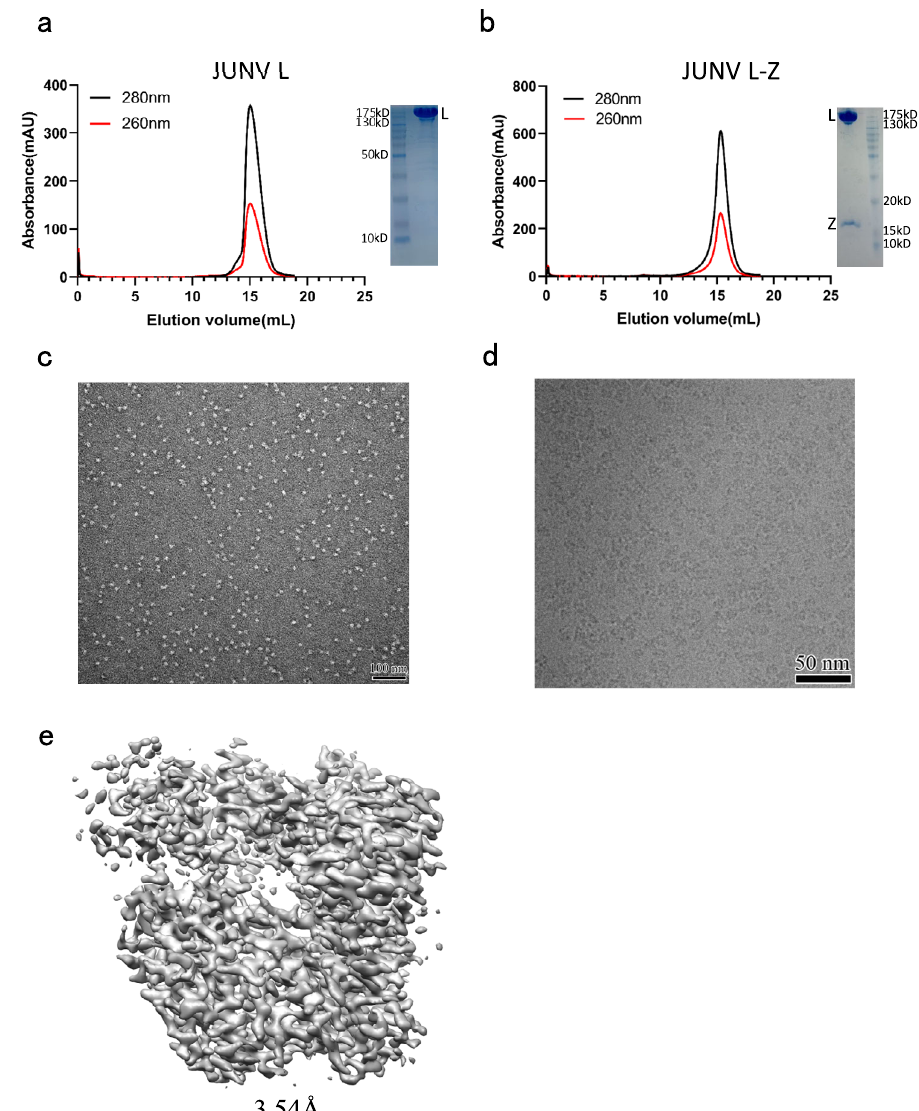
Fig. 1 Biochemical characterization and cryo-EM structure. a Elution pro fi le of the puri fi ed JUNV L protein on a Superose 6 Increase 10/300 GL size- exclusion column. SDS-PAGE was performed to assess the quality of L protein (repeated ≥ 3 times). b Elution pro fi le of the puri fi ed JUNV L – Z complex on a Superose 6 Increase 10/300 GL size-exclusion column. SDS-PAGE was performed to assess the quality of L – Z complex (repeated ≥ 3 times). c A representative negative staining micrograph of JUNV L – Z complex (repeated ≥ 3 times). d A representative cryo-EM micrograph of JUNV L – Z complex (out of ~6400 micrographs). e The fi nal cryo-EM density map of JUNV L – Z